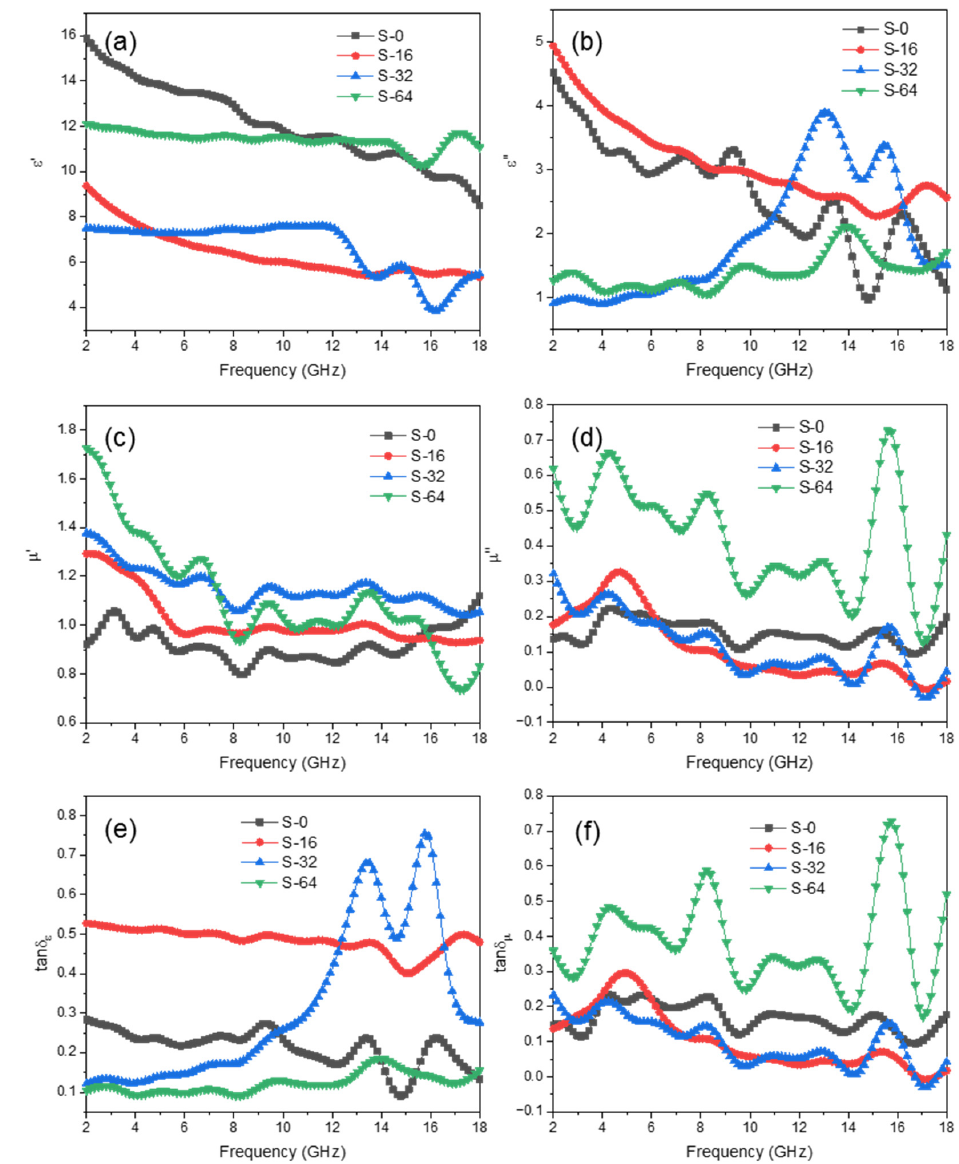
Figure 5. Electromagnetic parameters of Co-Ni/C: ( a , b ) real and imaginary part of permittivity, ( c , d ) real and imaginary part of permeability, ( e , f ) dielectric and magnetic loss tangent.